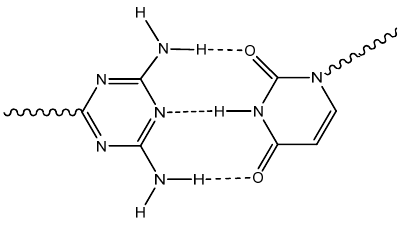
Figure 2. Interaction between triazine and uracil